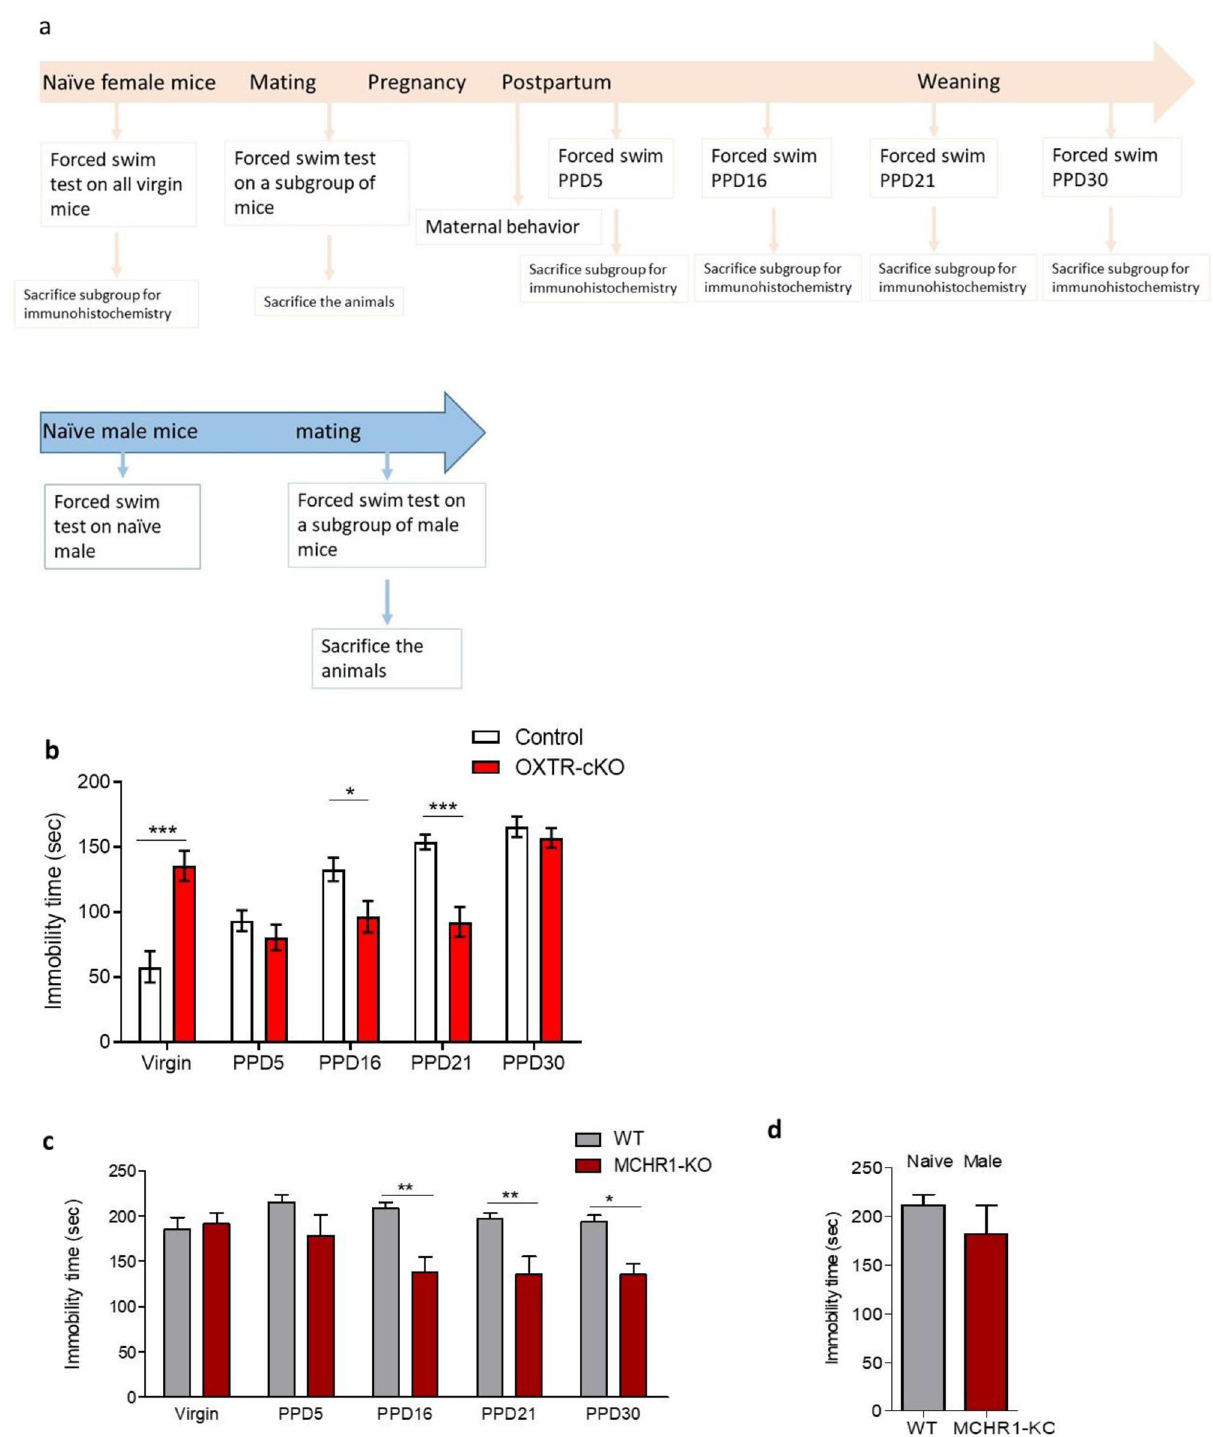
Figure 3. OXTR deletion from MCH neurons produces discrete effects on depressive behavior. ( a ) Schematic diagram of the behavioral experimental design. ( b ) Immobility times in control and OXTR-cKO female mice: two-way ANOVA analysis of immobility time revealed the following changes in OXTR-cKO mice: increase in virgin females, no change on PPD5, decrease on PPD16 and PPD21, and no change on PPD30 (Virgin: n control = 19, n OXTR-cKO = 19, *** P < 0.001; PPD5: n control = 24, n OXTR-cKO = 24, P > 0.05; PPD16: n control = 24, n OXTR-cKO = 24, * P < 0.05; PPD21: n control = 24, n OXTR-cKO = 24, *** P < 0.001, PPD30: n control = 10, n OXTR-cKO = 10, P > 0.05, Bonferroni post-test). ( c ) Immobility time in female WT and MCHR1-KO mice: immobility time in MCHR1-KO is not changed in virgin females and in PPD5, and is decreased in PPD16, PPD21 and PPD30 mice (Virgin: n WT = 7, n MCHR1-KO = 7, P > 0.05; PPD5: n WT = 6, n MCHR1-KO = 6, P > 0.05; PPD16: n WT = 8, n MCHR1-KO = 6, ** P < 0.01; PPD21: n WT = 7, n MCHR1-KO = 6, ** P < 0.01, PPD30: n WT = 6, n MCHR1-KO = 6, * P < 0.05, Bonferroni post-test). ( d ) Immobility times in naive control and OXTR-cKO male (n WT = 6, n MCHR1-KO = 6, P > 0.05, unpaired t